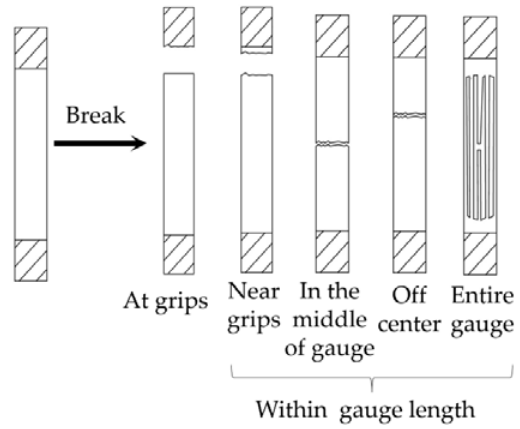
Figure 8. Major failure locations of natural rattan strips subjected to tensile loading in test 1.